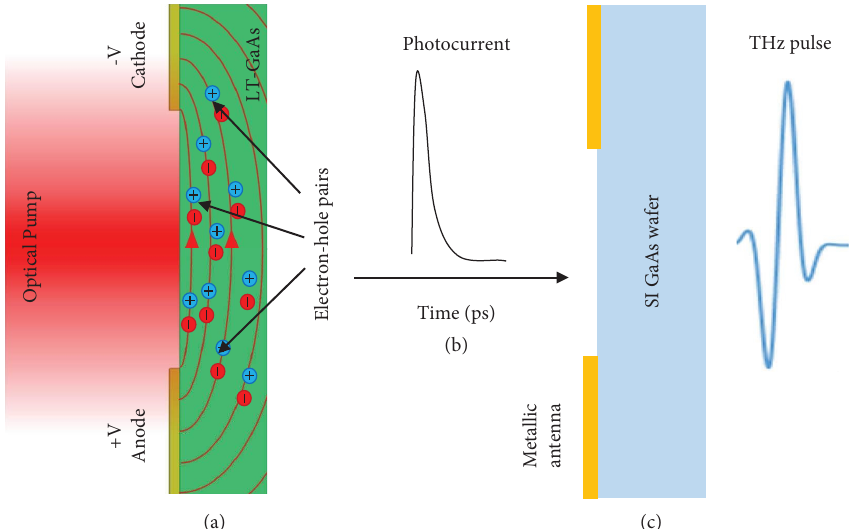
Figure 1: Conceptual diagram of THz generation in a PCA: (a) femtosecond laser beam excites electron-hole pairs in the LT-GaAs layer, (b) generated photocurrent pulse, and (c) metallic electrodes (antenna) excited by the photocurrent pulse in the gap to radiate THz pulse